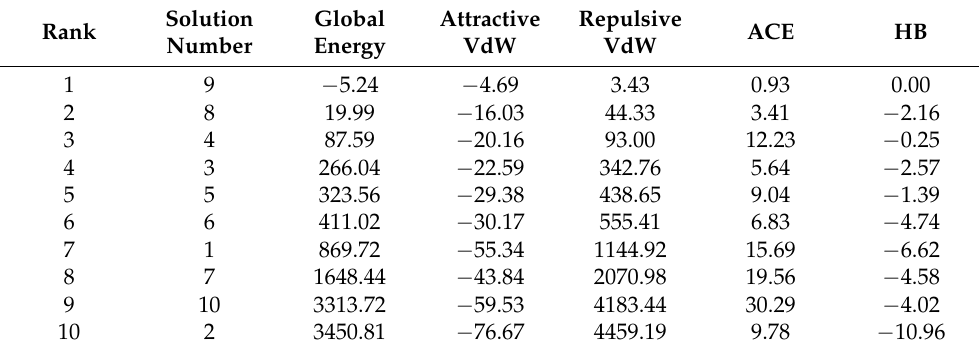
Table 11. FireDock solutions for MHC-II vaccine. In each of the terms below, the unit of energy is KJ · m − 1